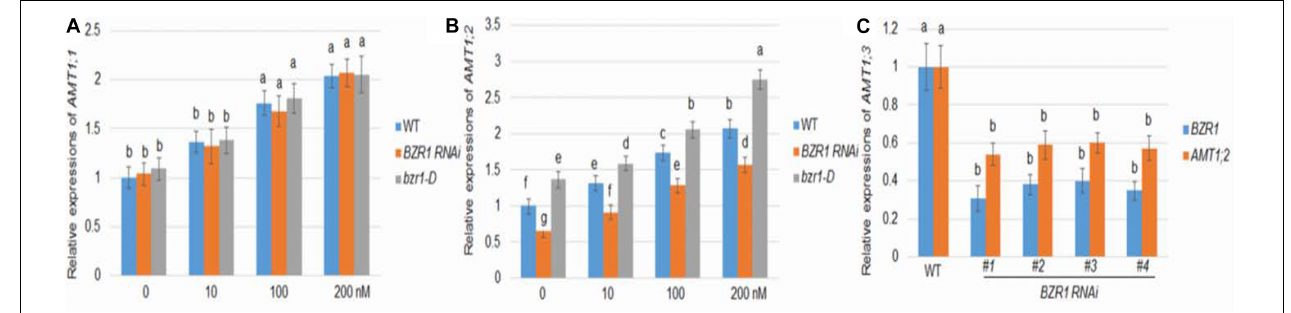
FIGURE 2 | BR-mediated AMT1 expression in BZR1 RNAi and BZR1 constitutively active bzr1-D plant roots. Rice plants were grown in distilled water for 7 days and then treated with 0, 10, 100, or 200 nM BL for 3 h. (A) The expression levels of AMT1;1 was measured by qRT-PCR. (B) The expression levels of AMT1;2 was measured by qRT-PCR. Ubiquitin was used to normalize the expression of each gene. Data represent means ± SE ( n = 3). (C) BZR1 and AMT1;2 expression levels in wild-type and BZR1 RNAi lines ( #1 - #4 ). Data indicate means ± SE ( n = 3). The experiments were repeated at least three times. Different letters represent statistically significant differences ( P <